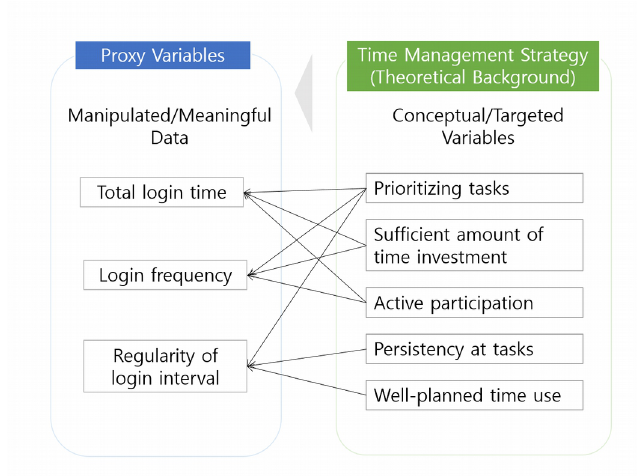
Figure 2. Three online log variables with their theoretical backgrounds (Jo, Kim, & Yoon, 2014) Learners with high abilities to prioritize tasks are able to better invest their time and effort on study,